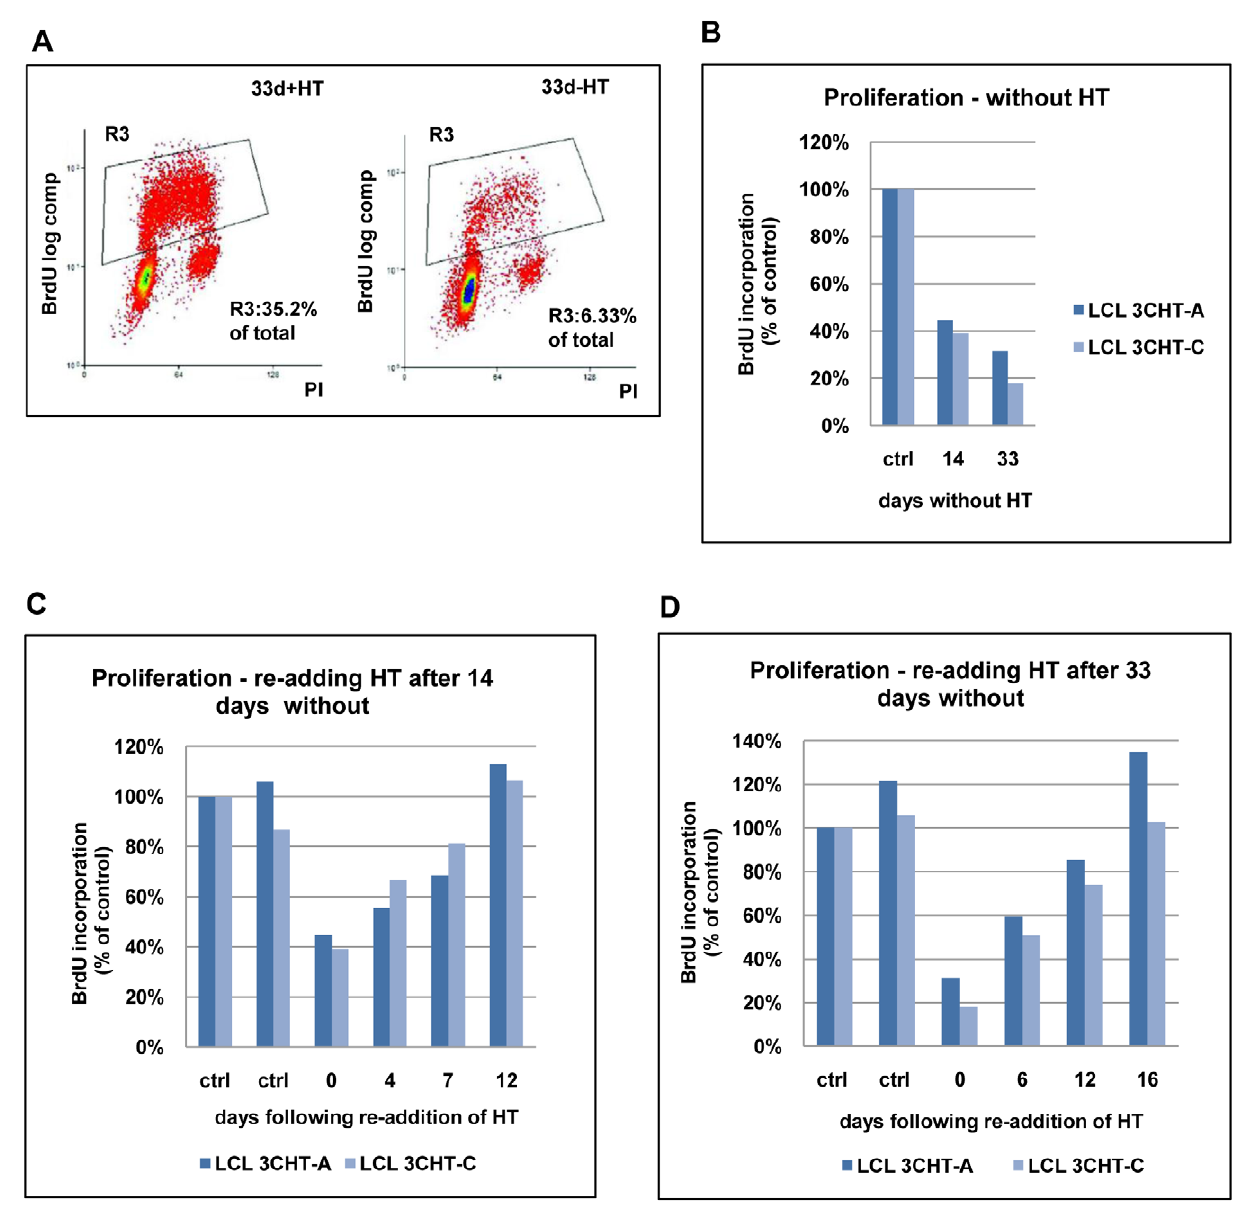
Figure 2. Proliferation of LCL 3CHT after inactivation and reactivation of EBNA3C. ( A ) LCL 3CHT cells were cultured either with HT ( + HT) or for 33 days after the removal of HT (-HT) from the growth medium. Cells were pulsed for 1 hour with BrdU, harvested, fixed and stained with anti- BrdU-FITC and propidium iodide. The cells were analysed by flow cytometry. The gated BrdU-positive population is reduced in the absence of HT. ( B ) Two LCL 3CHT (-A and -C) generated from independent 3CHT-BACs using PBL from a single donor were analysed as in (A) after 14 and 33 days without HT. Histograms show BrdU incorporation relative to the control, cycling population. The control (ctrl) was a proliferating population of LCL 3CHT grown in medium with HT. ( C ) LCLs 3CHT-A and -C were cultured for 14 days in the absence of HT (0) and BrdU-incorporation was assayed as in (A). The incorporation of BrdU was also assayed as above after 4, 7 and 12 days after re-adding HT. ( D ) A similar experiment was performed on cells cultured without HT for 33